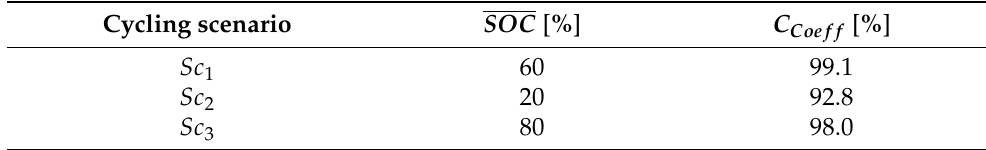
Table 3. Different operating conditions.